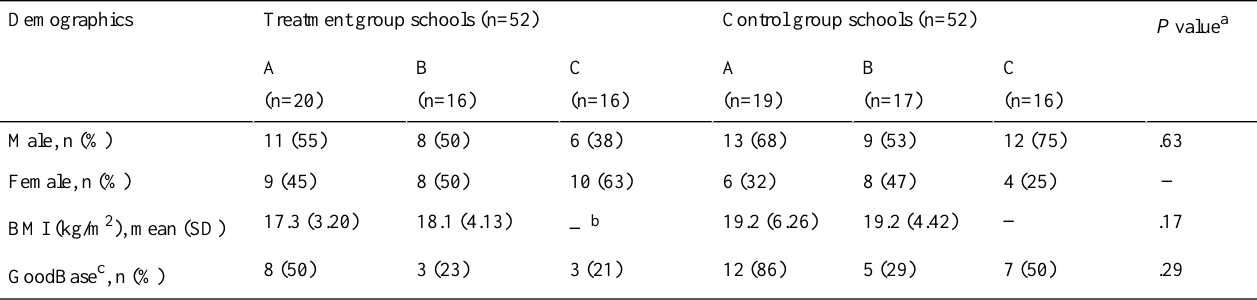
Table 1. Sample size, random assignments, and demographic distribution.